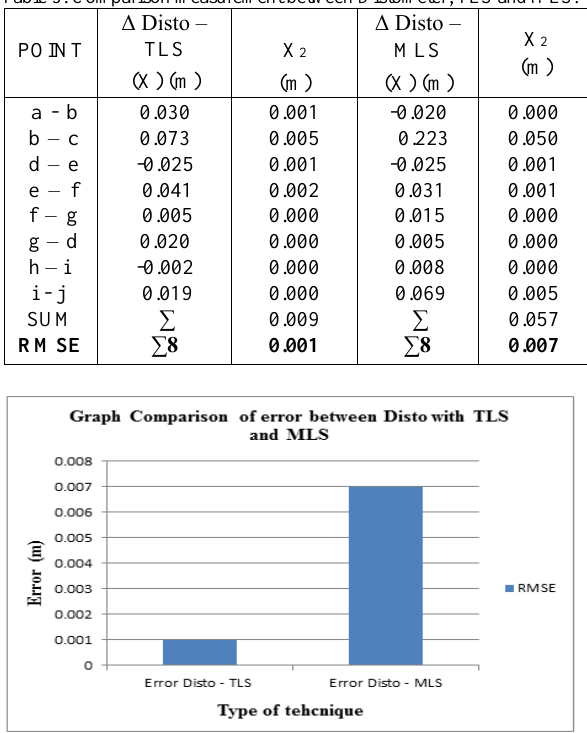
Figure 12: Graph comparison of error between Distometer with TLS and MLS.